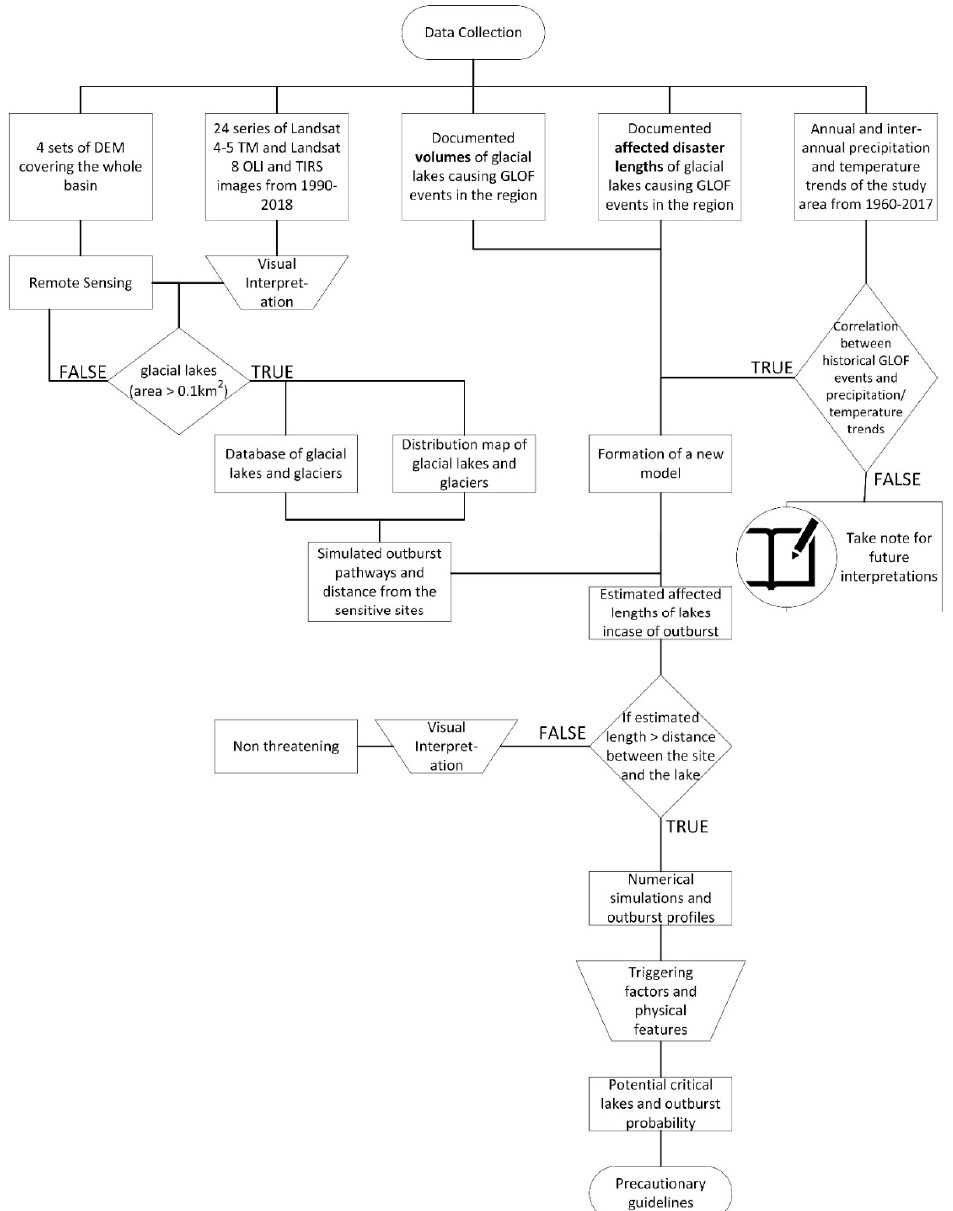
Figure 2. Methodology. Figure 2.